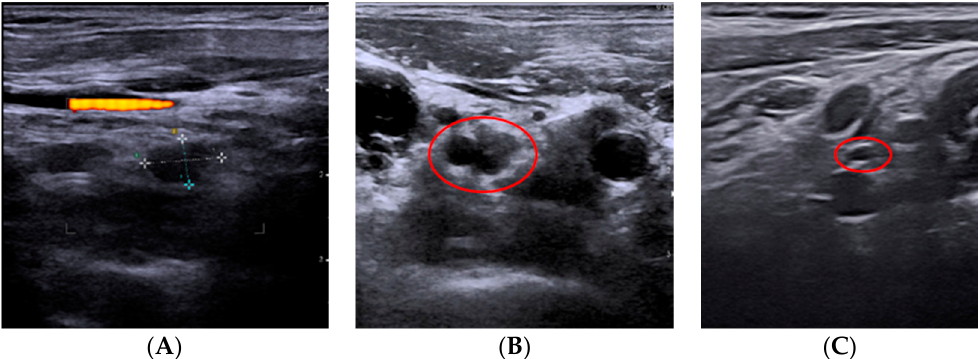
Figure 1. The images ( A ) show a lymph node recurrence to treat with laser ablation. Image ( B ) shows the tip of the laser fiber in the center of the lesion before the start of the ablative treatment. Image ( C ) shows the ultrasound follow-up at 6 months. The lymph node recurrence appears as a hypoechoic area with a hyperechoic halo (image of scarring fibrosis).